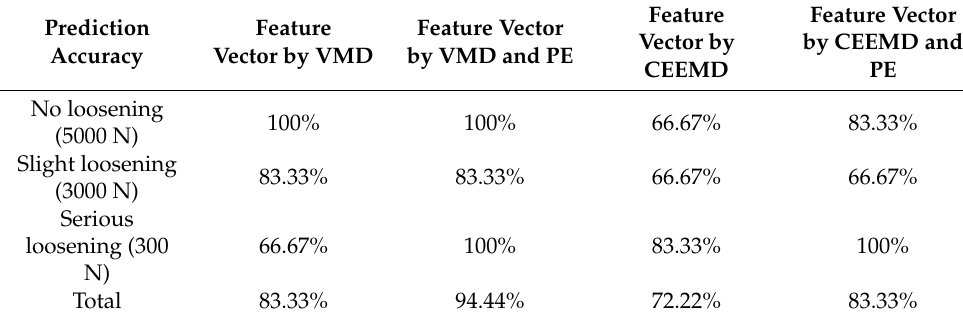
Table 2. Prediction accuracy under the condition of equal-amplitude pulse